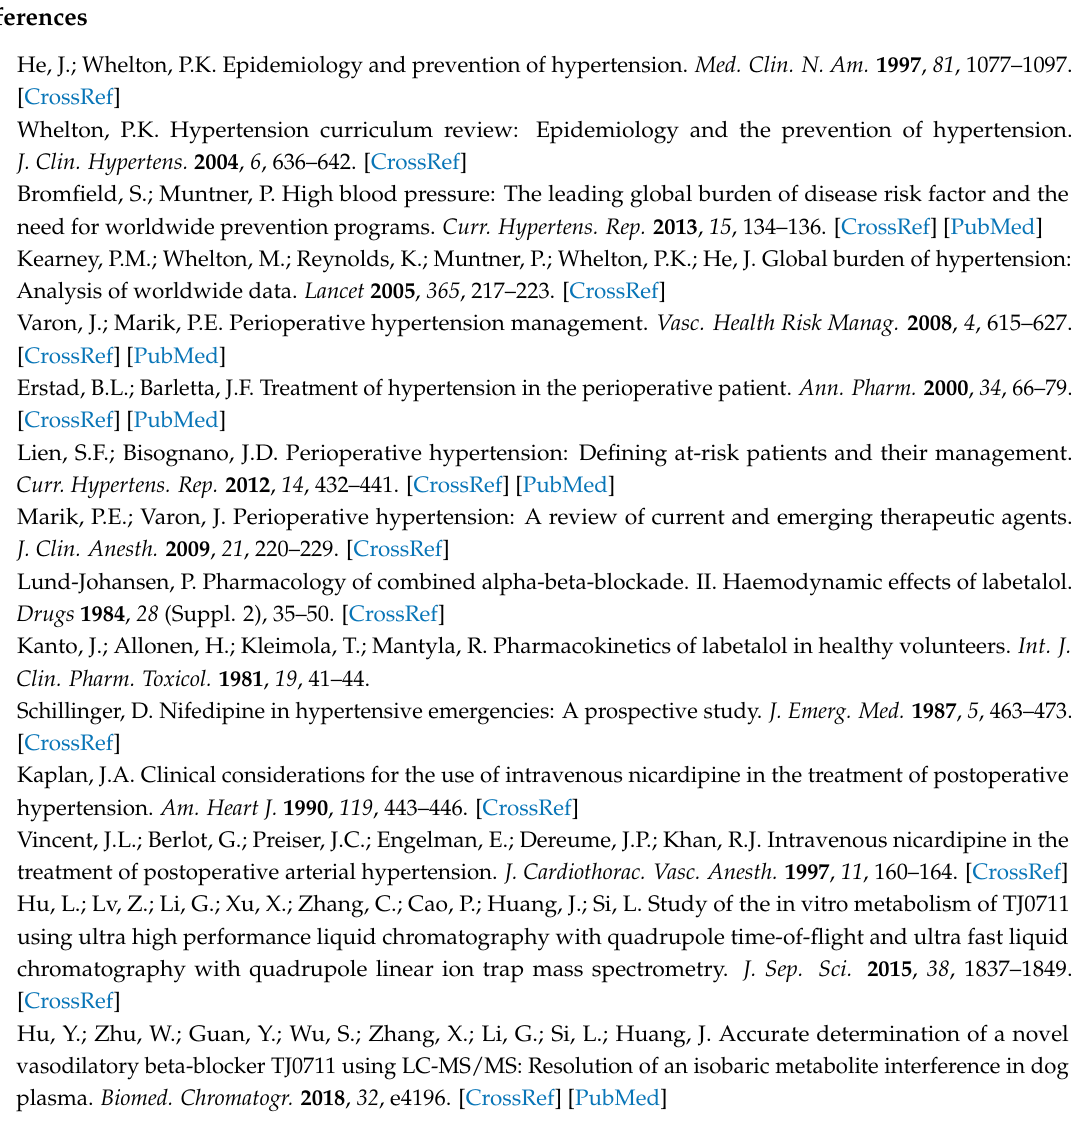
Figure S1. Relationship between ln(PK of metabolites) and ln(Dose of TJ0711). (A) C max of M1. (B) AUC 0– ∞ of M1. (C) C max of M3. (D) AUC 0– ∞ of M3. The full lines are the fitted values calculated by the power model and the dotted lines, which are the 95% prediction band. Table S1. Matrix effect of TJ0711, M1, M3, and IS in hemolysis sample ( n = 6). Table S2. The stability of analytes in whole blood ( n =